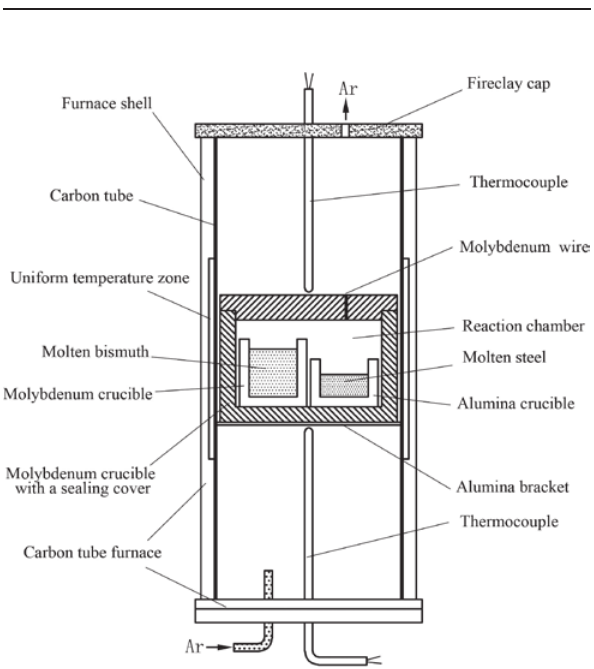
Fig. 1: A schematic of the apparatus for the bismuth solubility experiment